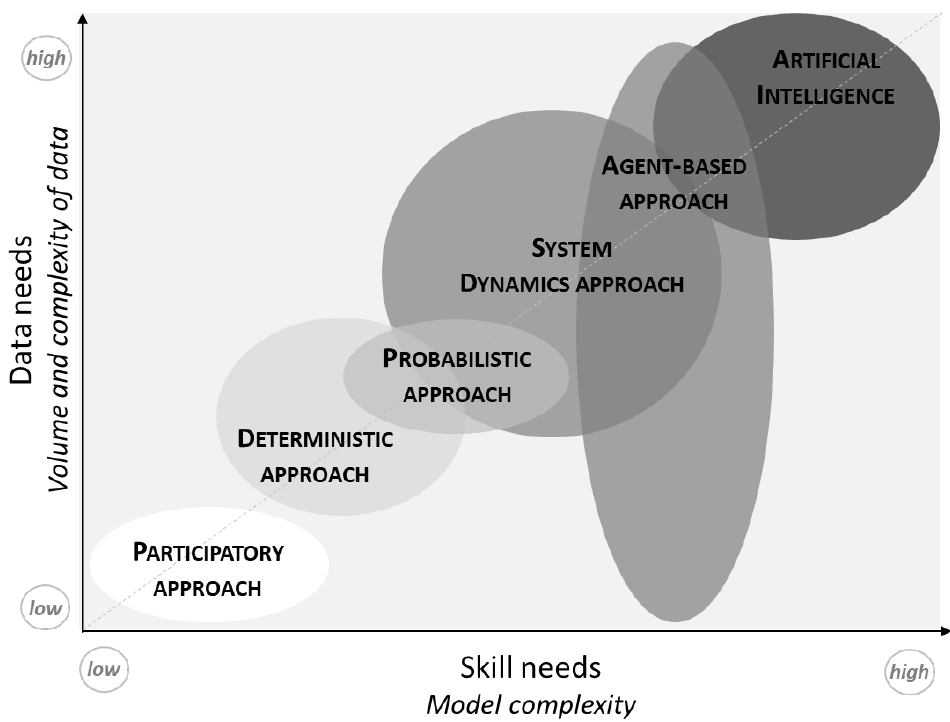
Figure 2. Modelling approaches and associated complexity.